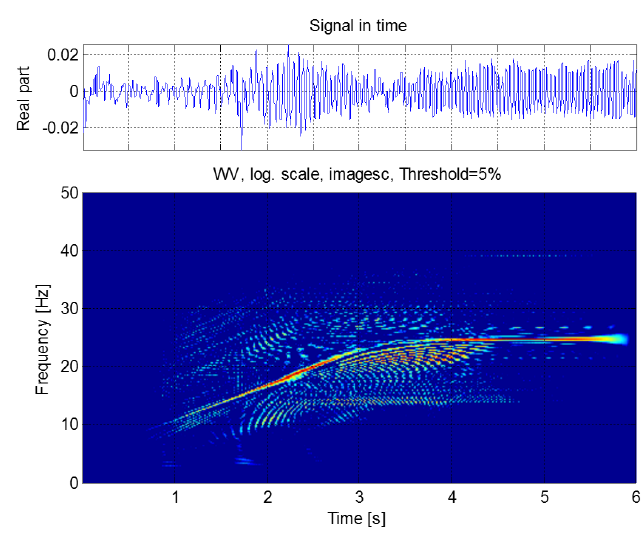
Figure 18. Components of the start-up current in the frequency band [2.5, 39.06] Hz, which includes the main mixed eccentricity components ( top ), and Wigner–Ville distribution of these components ( bottom ).